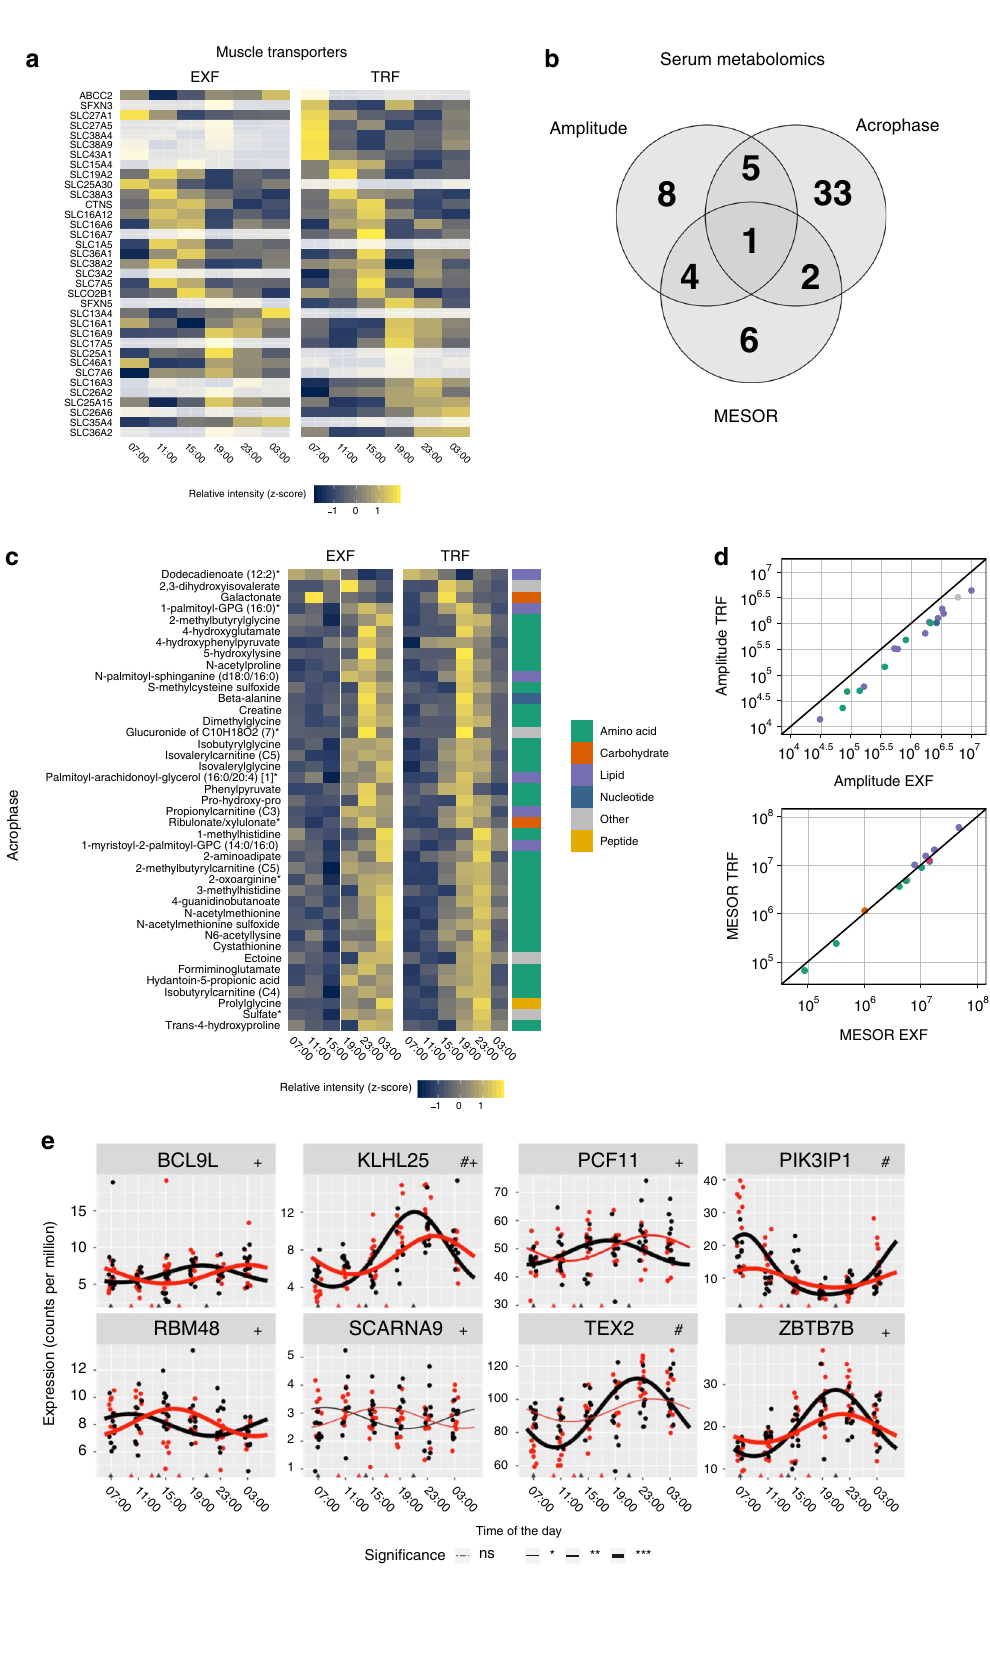
(16:0)*Galactonate2,3-dihydroxyisovalerateDodecadienoate (d18:0/16:0)N-acetylproline5-hydroxylysine4-hydroxyphenylpyruvate4-hydroxyglutamate2-methylbutyrylglycine1-palmitoyl-GPG sulfoxideN-palmitoyl-sphinganine (7)*DimethylglycineCreatineBeta-alanineS-methylcysteine (C5)IsobutyrylglycineGlucuronide of C10H18O2 [1]*IsovalerylglycineIsovalerylcarnitine (C3)Pro-hydroxy-proPhenylpyruvatePalmitoyl-arachidonoyl-glycerol (16:0/20:4) (14:0/16:0)1-methylhistidineRibulonate/xylulonate*Propionylcarnitine (C5)2-aminoadipate1-myristoyl-2-palmitoyl-GPC sulfoxideN-acetylmethionine4-guanidinobutanoate3-methylhistidine2-oxoarginine*2-methylbutyrylcarnitine acidFormiminoglutamateEctoineCystathionineN6-acetyllysineN-acetylmethionine (C4)Hydantoin-5-propionic Trans-4-hydroxyprolineSulfate*ProlylglycineIsobutyrylcarnitine